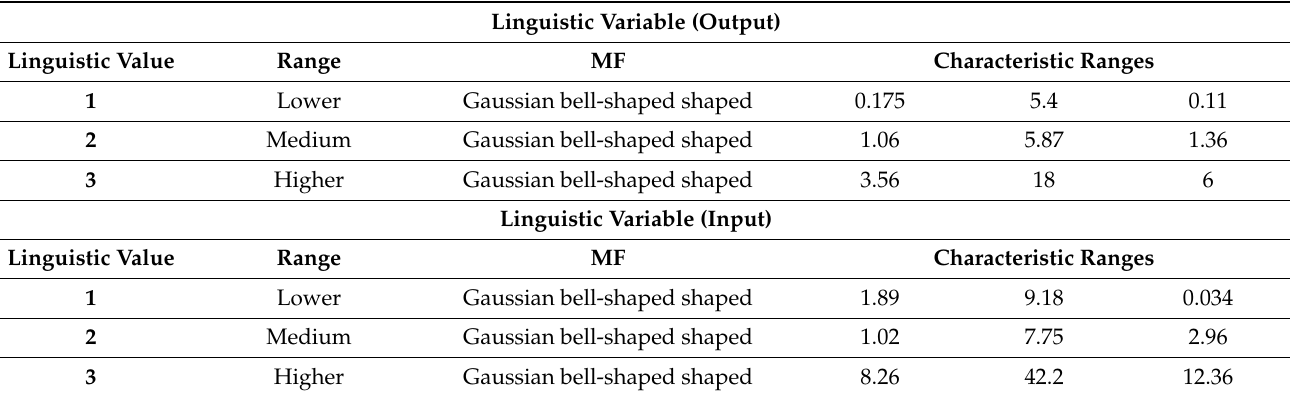
Table 5. Linguistic functions and MF’s for control inputs and outputs.